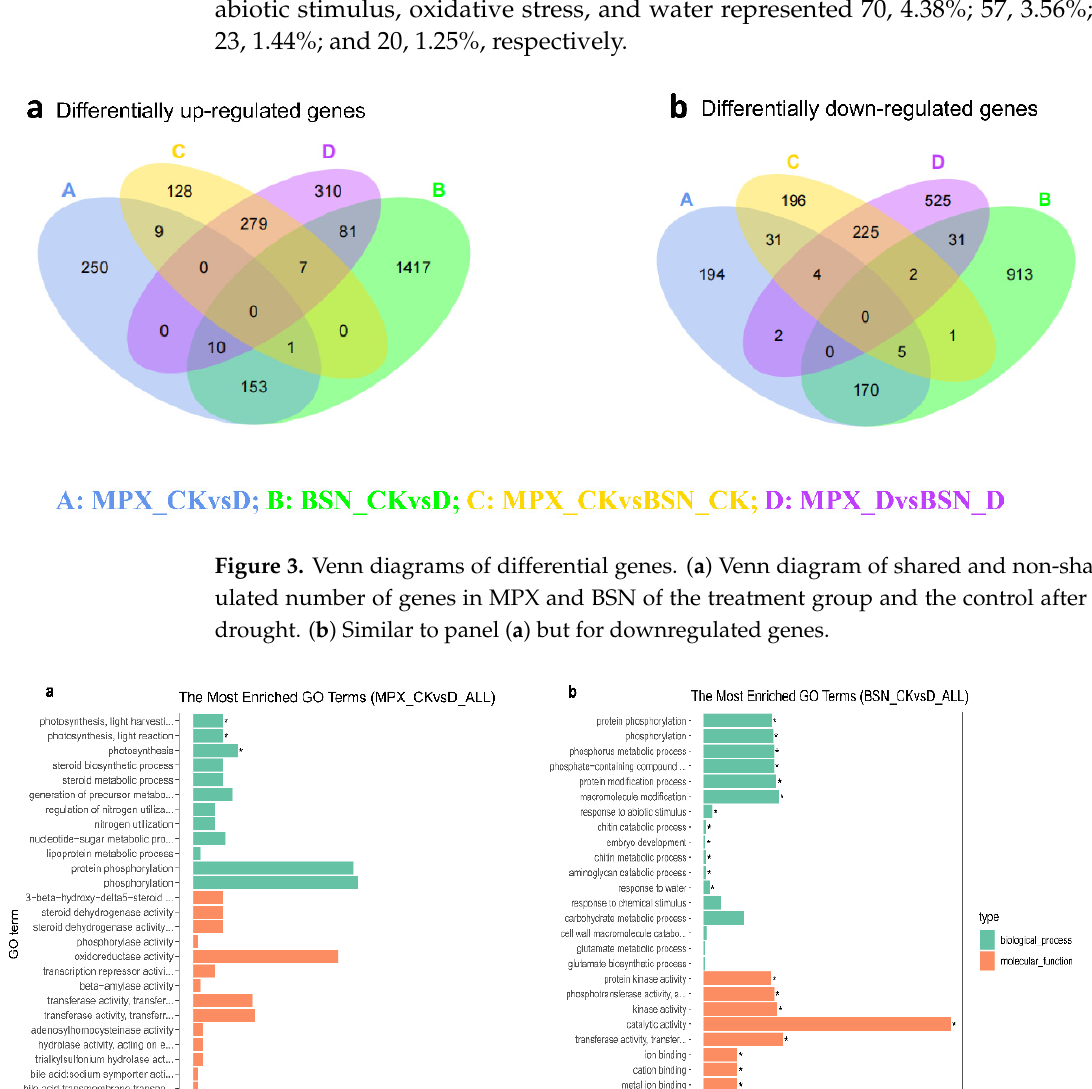
Figure 3. Venn diagrams of differential genes. ( a ) Venn diagram of shared and non ‐ shared upreg ‐ ulated number of genes in MPX and BSN of the treatment group and the control after 21 days of drought. ( b ) Similar to panel ( a ) but for downregulated genes.